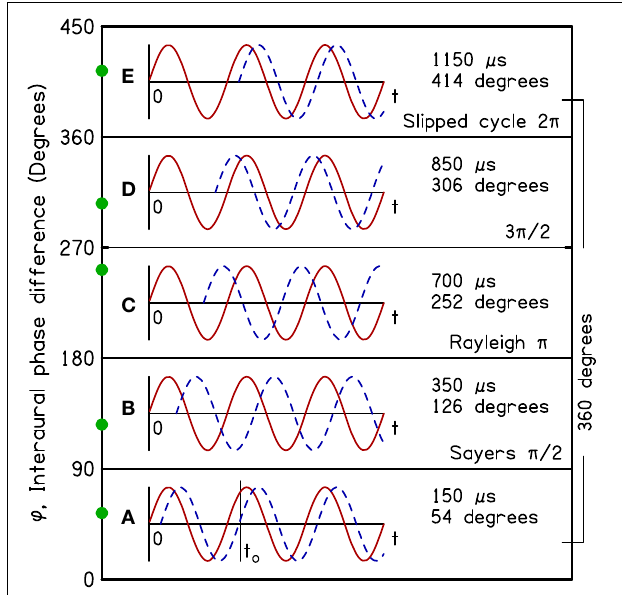
FIGURE 1 | Tones in the right ear (red) and left ear (blue and dashed) as functions of time and with particular interaural phase differences (IPD) as indicated on the vertical axis to illustrate different regions of IPD. The boundaries between regions, separated by 90 ◦ , are logically and perceptually important in sound localization.